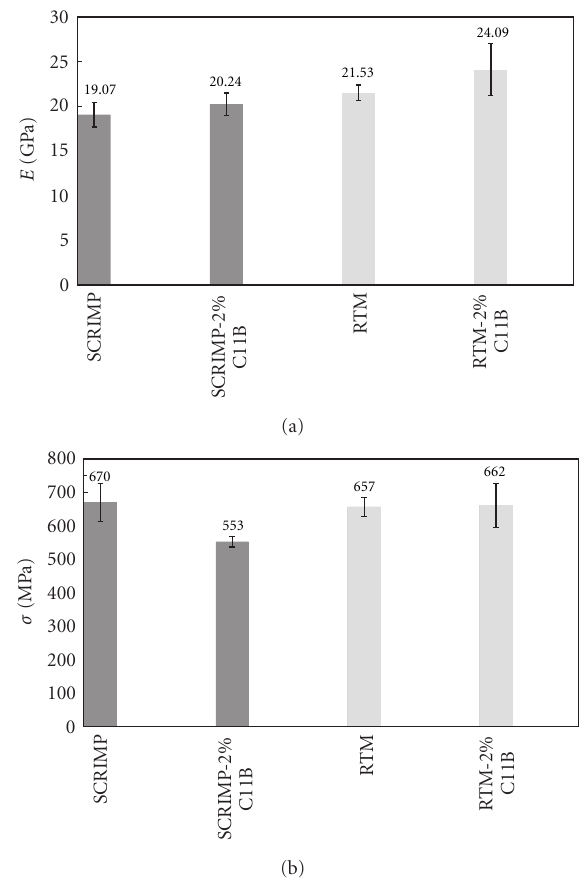
Figure 10: Mechanical properties of composite laminates made by RTM and SCRIMP processes: (a) flexural modulus, (b) utimate